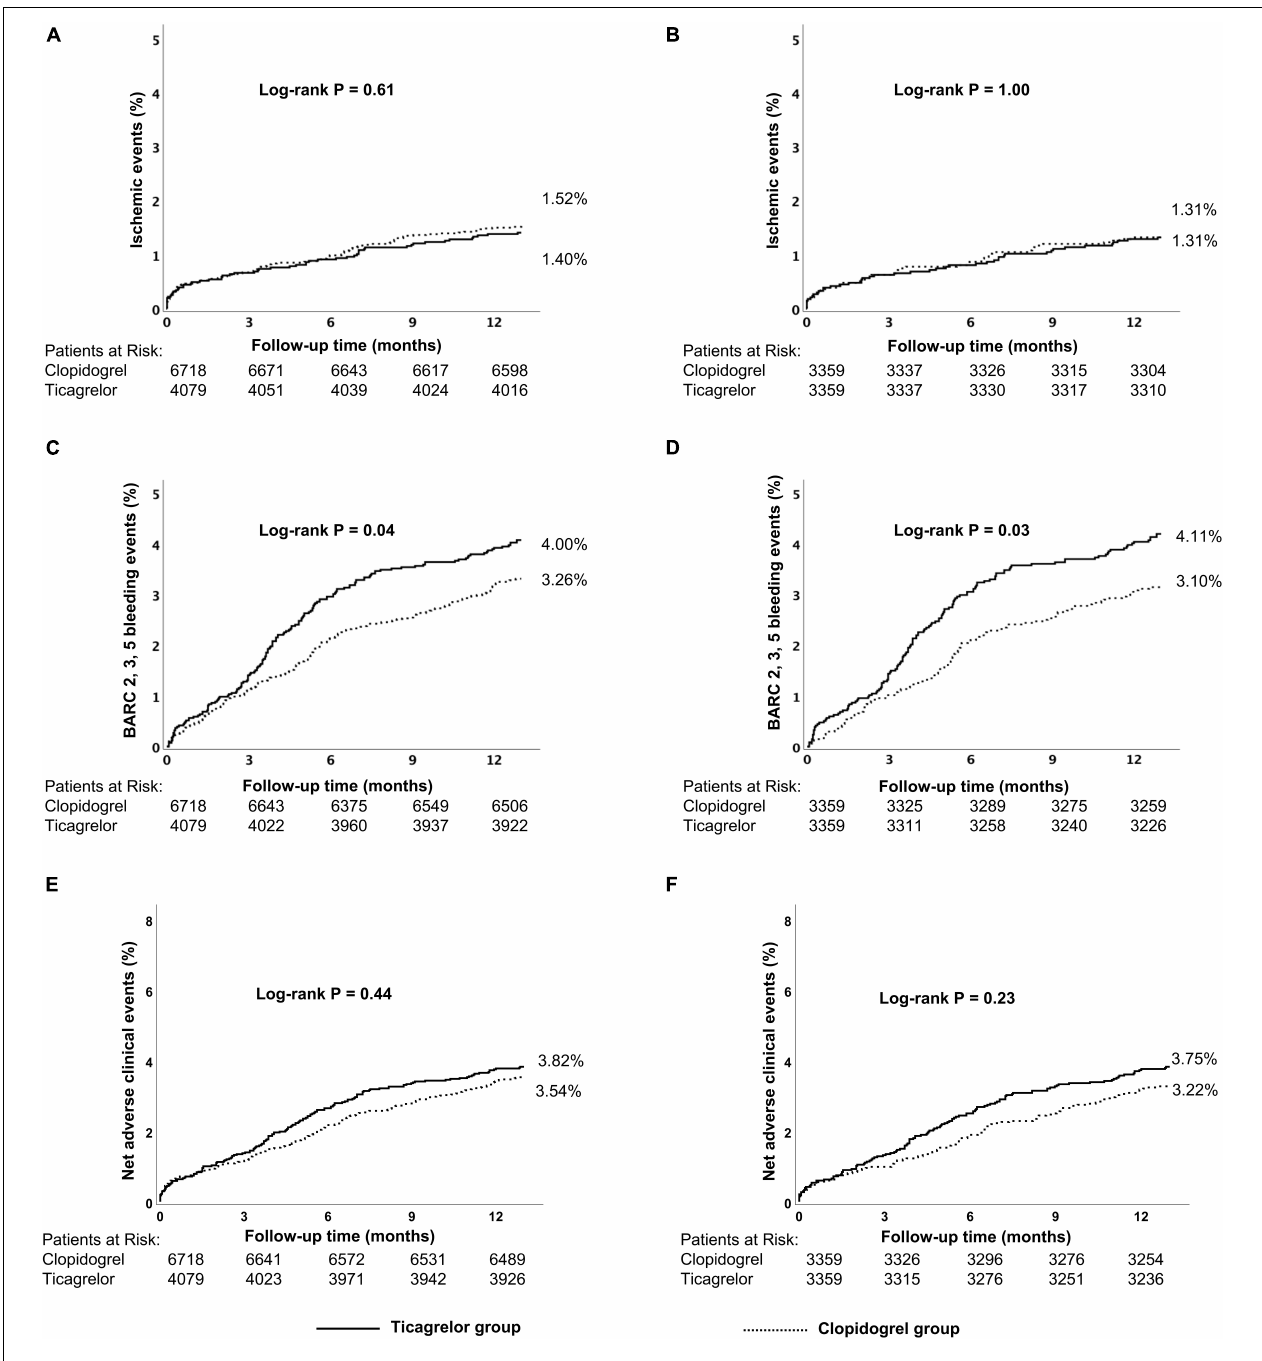
FIGURE 3 | Kaplan–Meier cumulative event curves for a 12-month period for patients treated with ticagrelor or clopidogrel in the low-risk group, including primary endpoints ischemic events (A,B) BARC 2, 3, 5 bleeding (C,D) and net adverse clinical events (NACEs) (E,F) . Before propensity score matching (A,C,E) ; after propensity score matching (B,D,F) . Ischemic events, defined as a composite of cardiac death, MI, and stroke.Net adverse clinical events (NACEs), defined as a composite of all-cause death, myocardial infarction, stroke, and BARC type 3, 5 bleeding events. BARC, Bleeding Academic Research